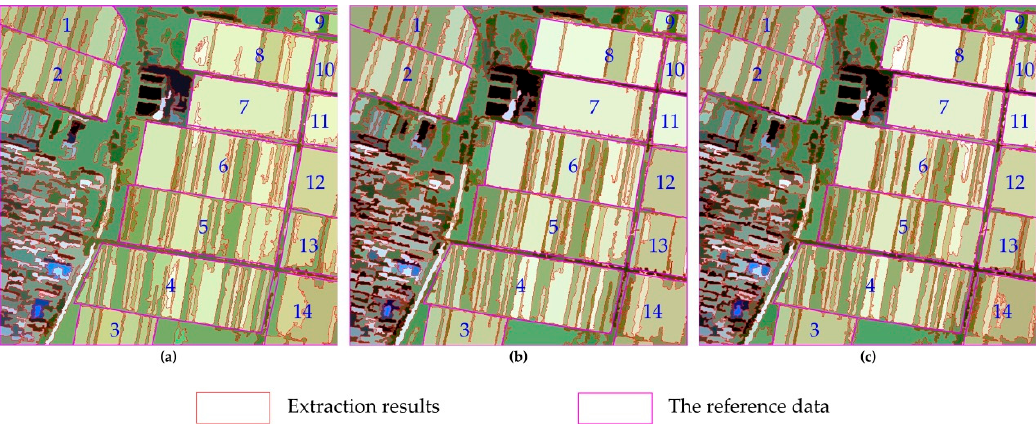
Figure 10. Comparison of the extracted cultivated land boundaries using ( a ) RGB-RMWS, ( b ) Lab-RMWS, and ( c ) Luv- RMWS with the reference data. Table 6. Statistics of the comparison experiment derived from the three methods.